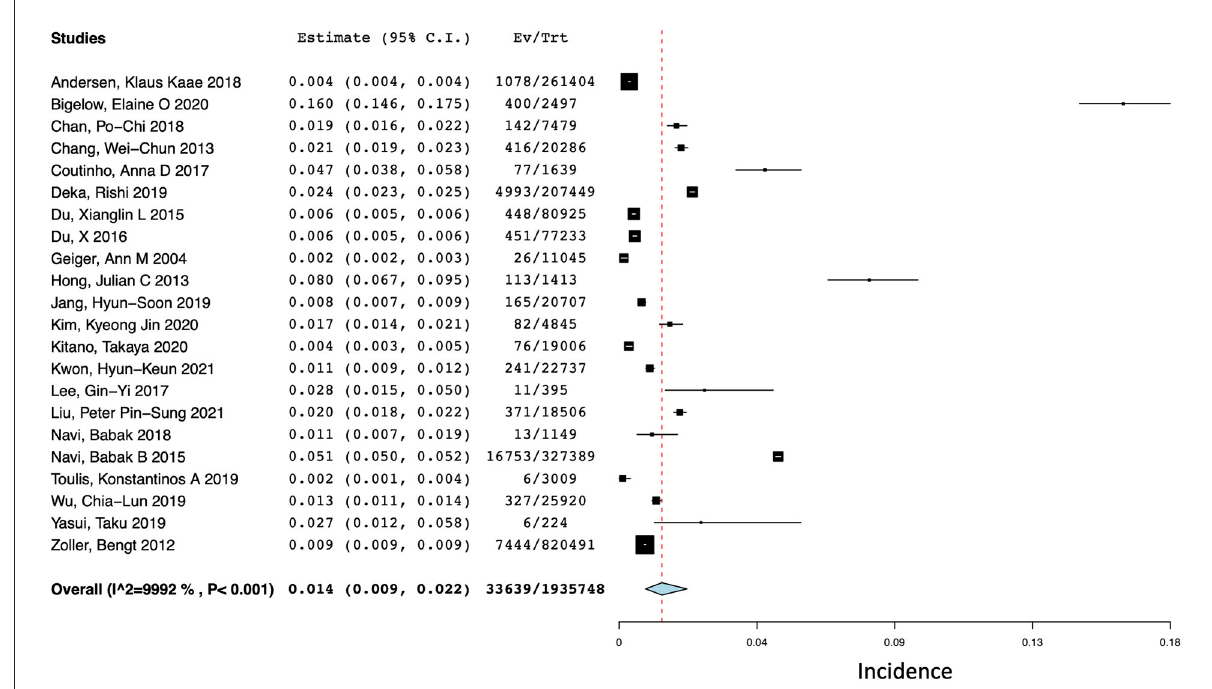
FIGURE2 Forest plot of the pooled incidence of total stroke (ischemic and hemorrhagic) at 1 year after a diagnosis of